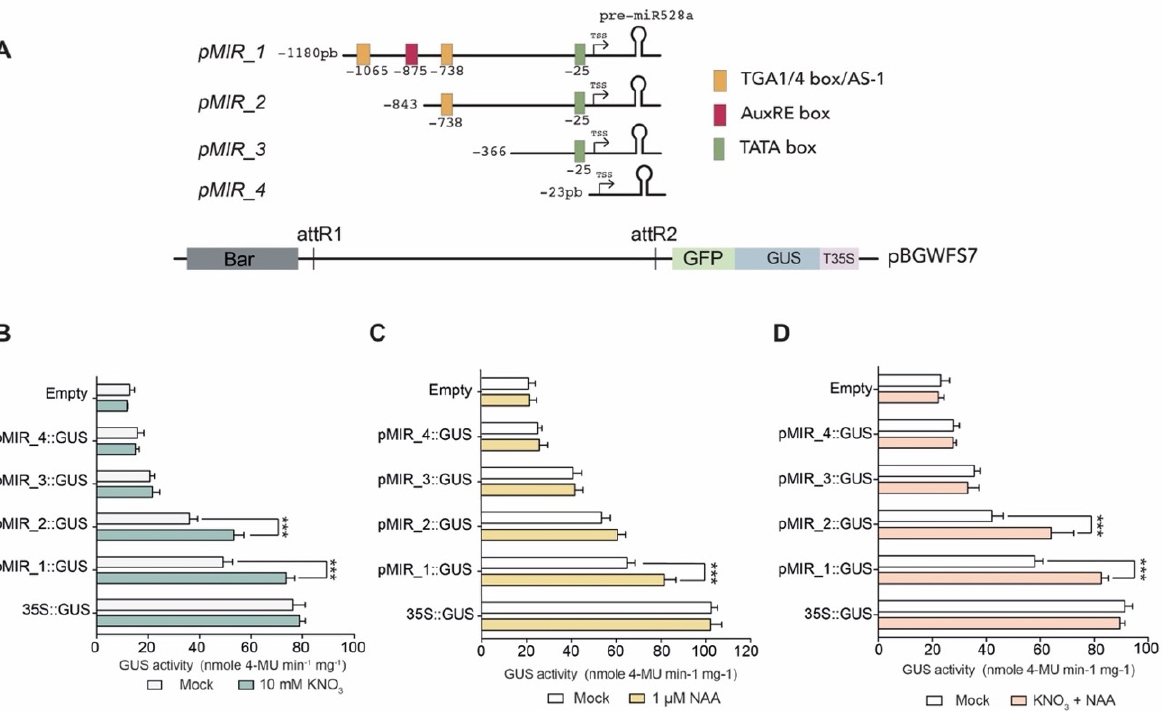
Figure 5. Dissection of cis -elements required for transcriptional up-regulation of miR528 by nitrate and auxins. ( A ) Constructs were generated including the MIR528a full promoter (pMIR_1) or 5 ′ consecutive deletions (pMIR_2-4) upstream of eGFP and GUS reporter genes (green and blue boxes, respectively). The nucleotide position of each deletion fragment is indicated at the left on each panel. Colored boxes represent relevant cis -acting elements. ( B – D ) GUS activity was evaluated by fluorometric assay on maize protoplasts transfected with each construct under nitrate ( B ), auxin ( C ) , or a combination of both treatments ( D ). The 35S CaMV:GUS construct was used as a positive control. Transfection with the vector lacking a promoter (Empty) was used as a negative control. Data represent the mean ± S.E.M. of three independent replicates with three technical replicates each (*** p < 0.001, paired t test).